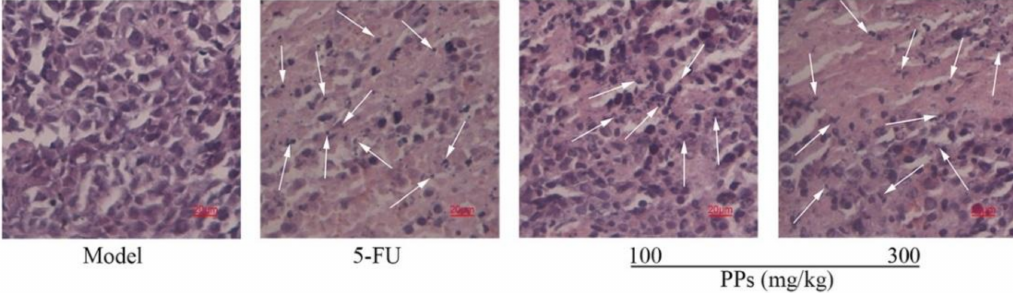
Figure 6. Effects of PPs on the histological morphology of tumor tissues in tumor-bearing mice using H&E staining under optical microscope (magnification, × 400). The arrow heads indicated the apoptotic cell nuclear